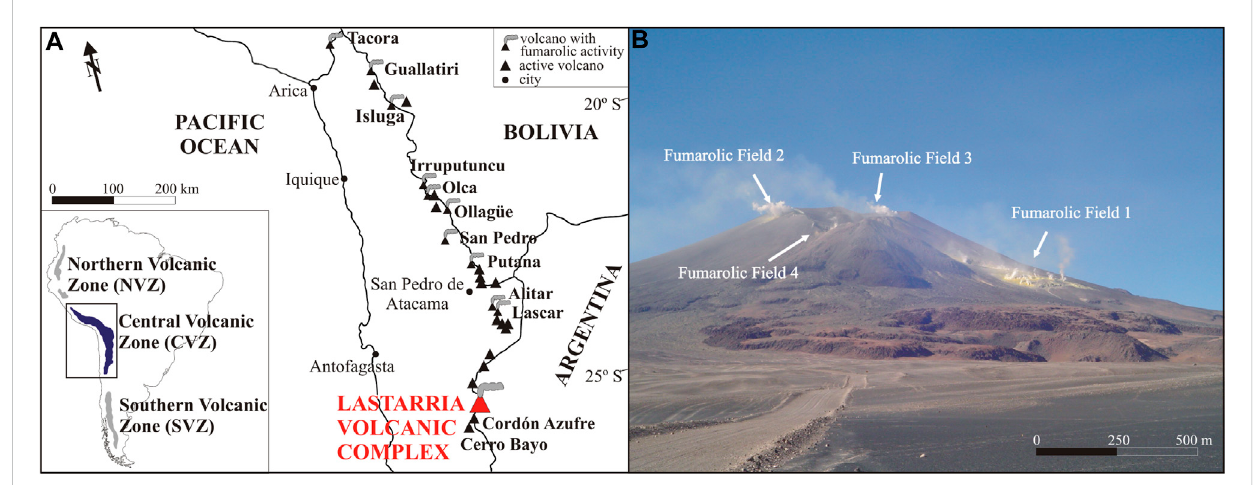
FIGURE 1 (A) Location map of the Lastarria Volcanic Complex and (B) picture of the 4 fumarolic fi elds (seen from the